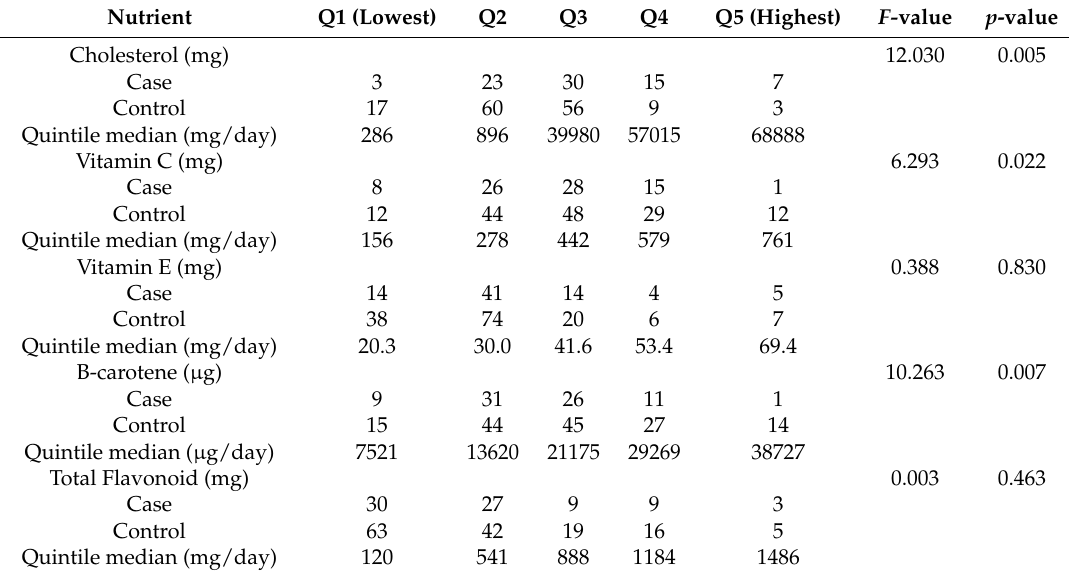
Table 3. Distribution of 42 cases with either glaucoma, age-related macular degeneration, cataracts, or a combination of the three, and 149 control subjects, by marginal quintiles of daily intake of micronutrients.